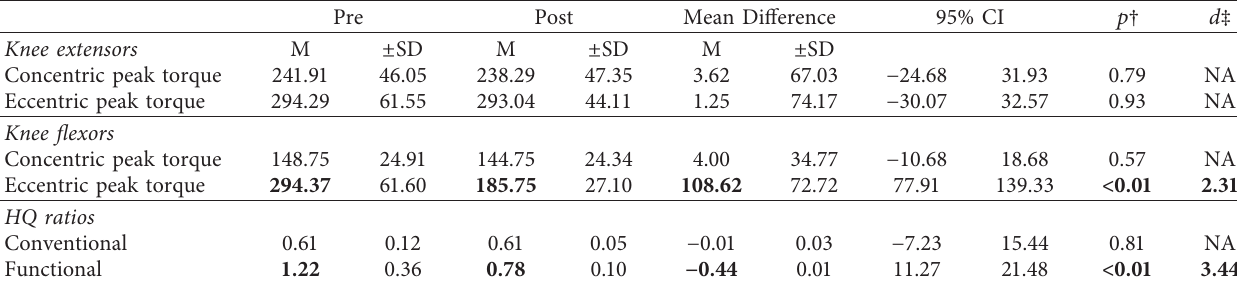
Table 3: Team B strength values before (pre) and after (post) quarantine